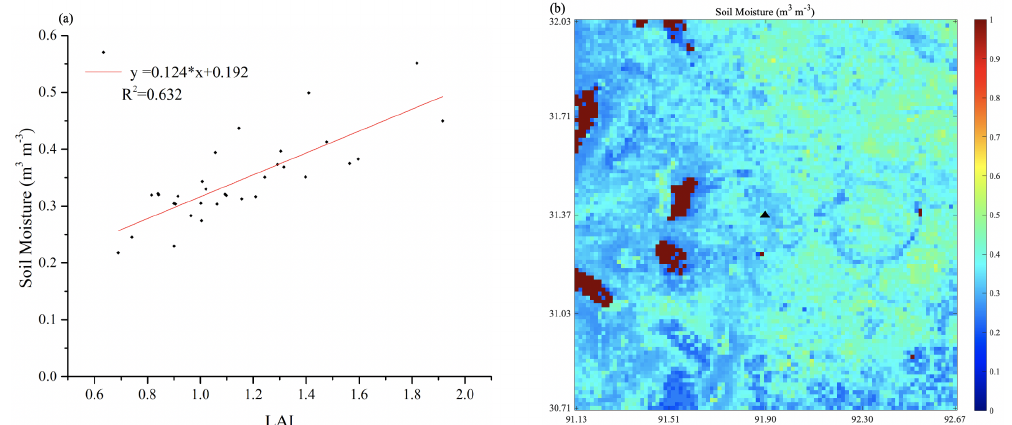
Figure 2. (a) Relationship between leaf area index (LAI) from Moderate Resolution Imaging Spectroradiometer (MODIS) and the observed soil moisture at 5cm. (b) Modified soil moisture in the innermost layer of wrfinput. The triangle indicates the location of site BJ/Nagqu. The 5cm soil moisture of the land surface in the study area varies from 0.2 to 0.5m 3 m − 3 . The red grid in (b) represents the lakes in the study area, where the soil moisture is close to 1.0mm 3 m − 3